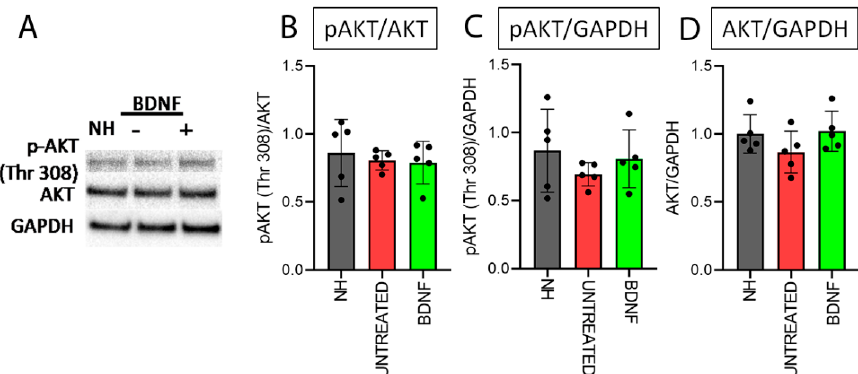
Figure 7. Protein quantification of AKT and pAKT (Thr 308). ( A ) Representative Western blot bands (the original whole Western blot bands are shown in Supplementary Figure S1). Western blot analysis of pAKT/AKT ( B ), pAKT/GAPDH ( C ) and AKT/GAPDH ( D ) on organ of Corti samples from all the experimental groups. Histograms show mean ± SD; the dots indicate the densitometric values for individual samples ( n = 5; each sample is a pool of two organs of Corti).